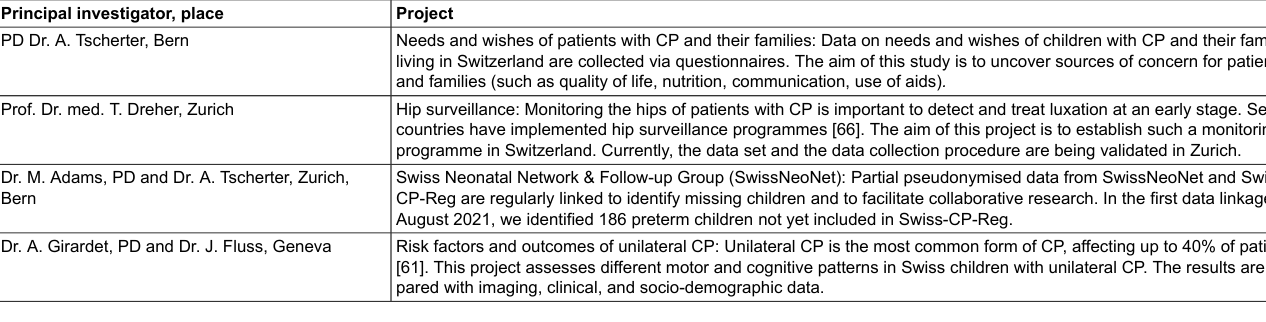
Table 3: Ongoing research projects and collaborations of the Swiss Cerebral Palsy Registry (September 2021). Principal investigator,